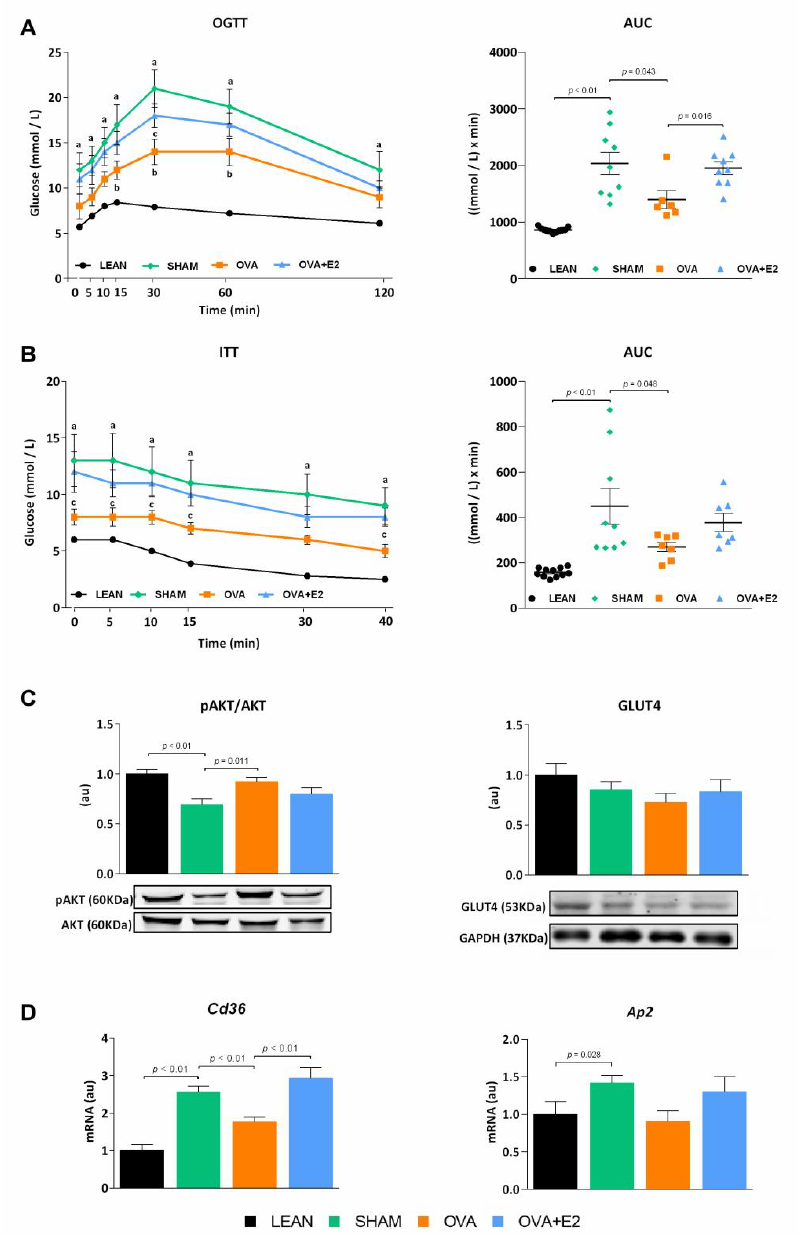
Figure 3. Ovariectomy and E2 treatment effects on oral glucose and insulin tolerance tests in female ZDF rats. ( A ) Oral Glucose Tolerance Test (OGTT). ( B ) Insulin Tolerant Test (ITT). In A and B, left panels represent blood glucose curves and right panels represent AUC. Blood samples were obtained from the tail vein at indicated time points. ( C ) Ratio of pAKT/AKT and protein levels of GLUT4 in WAT. ( D ) Cd36 and Ap2 mRNA expression levels in WAT. AUC, area under the curve; AKT, protein kinase B; GAPDH: glyceraldehyde-3-phosphate dehydrogenase; GLUT4, glucose transporter type 4; Cd36 , cluster of differentiation 36; Ap2 , adaptor protein 2. In C pAKT protein bands were normalized to total AKT protein intensity, and GLUT4 protein bands were normalized to GAPDH loading control. mRNA levels were normalized to housekeeping Gapdh expression. In C and D, data are expressed in arbitrary units (au) related to LEAN group. Values are expressed as the mean ± SEM. Differences between obese-diabetic (SHAM) and control (LEAN) animals were analyzed by Student’s t -test. Differences between obese-diabetic groups with different hormonal manipulation were analyzed by One-way ANOVA with Fisher’s LSD post-hoc test. Student’s t -test: a, SHAM vs. LEAN. One-way ANOVA: b, OVA or OVA + E2 vs. SHAM; c, OVA + E2 vs.